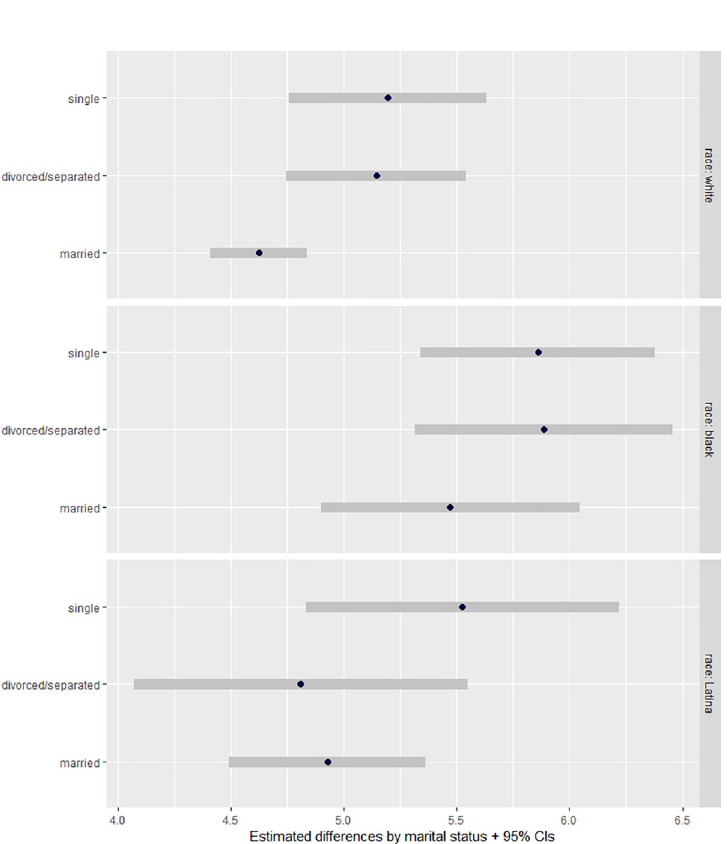
Fig 3. Predicted levels of legal abortion support by marital status and racial/ethnic group. Source: 2012 American National Election Study. CI = Confidence Interval. white: n = 221 single, n = 237 divorced/separated, n = 881 married; black: n = 189 single, n = 140 divorced/separated, n = 132 married; Latina: n = 94 single, n = 78 divorced/separated; n = 201 married. Effects were adjusted for age, income, employment status, education, having children (eighteen or younger) at home, religiosity (frequency of church attendance) and political